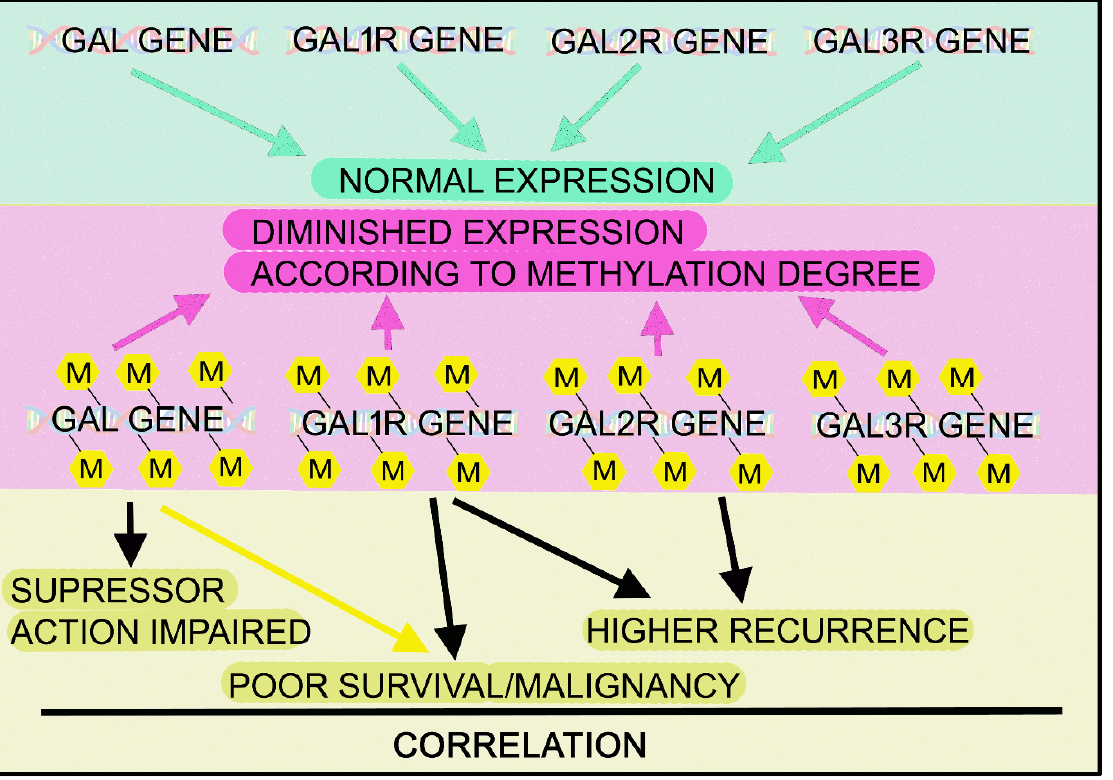
Figure 6. Effects of the epigenetic alterations in the galaninergic system: higher recurrence, malig- nancy and poor survival. Methylation (M)/hypermethylation (M,M,M) of GAL/GALR